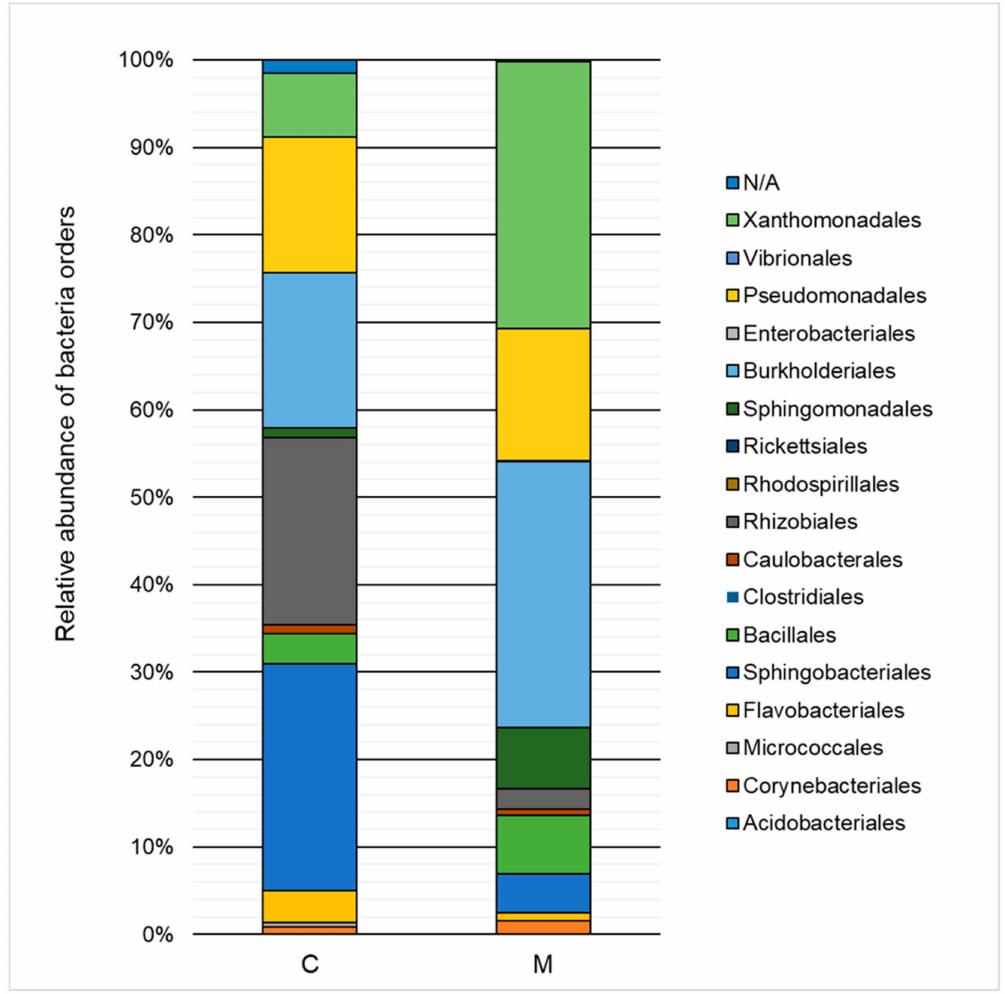
Figure 4. Relative abundance of bacterial orders in the control sample (C) and in a sample containing 150 mg · L − 1 of heavy metals (M) after 168 h of the biodegradation process.